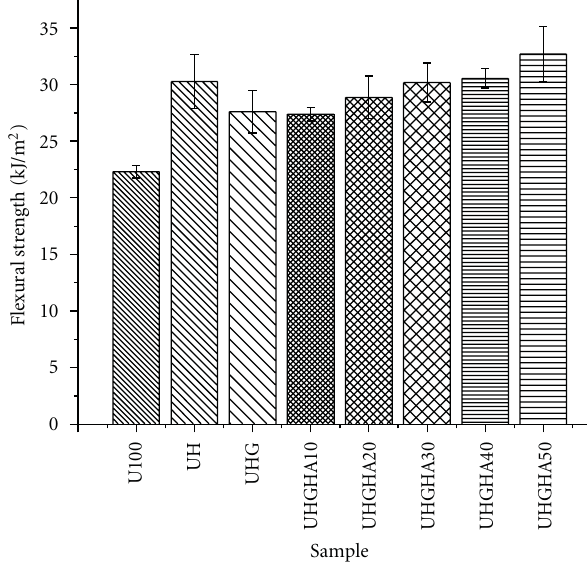
Figure 5: Flexural strength of UHMWPE/HDPE, UHMWPE/ HDPE/PEG blends and UHMWPE/HDPE/PEG/HA